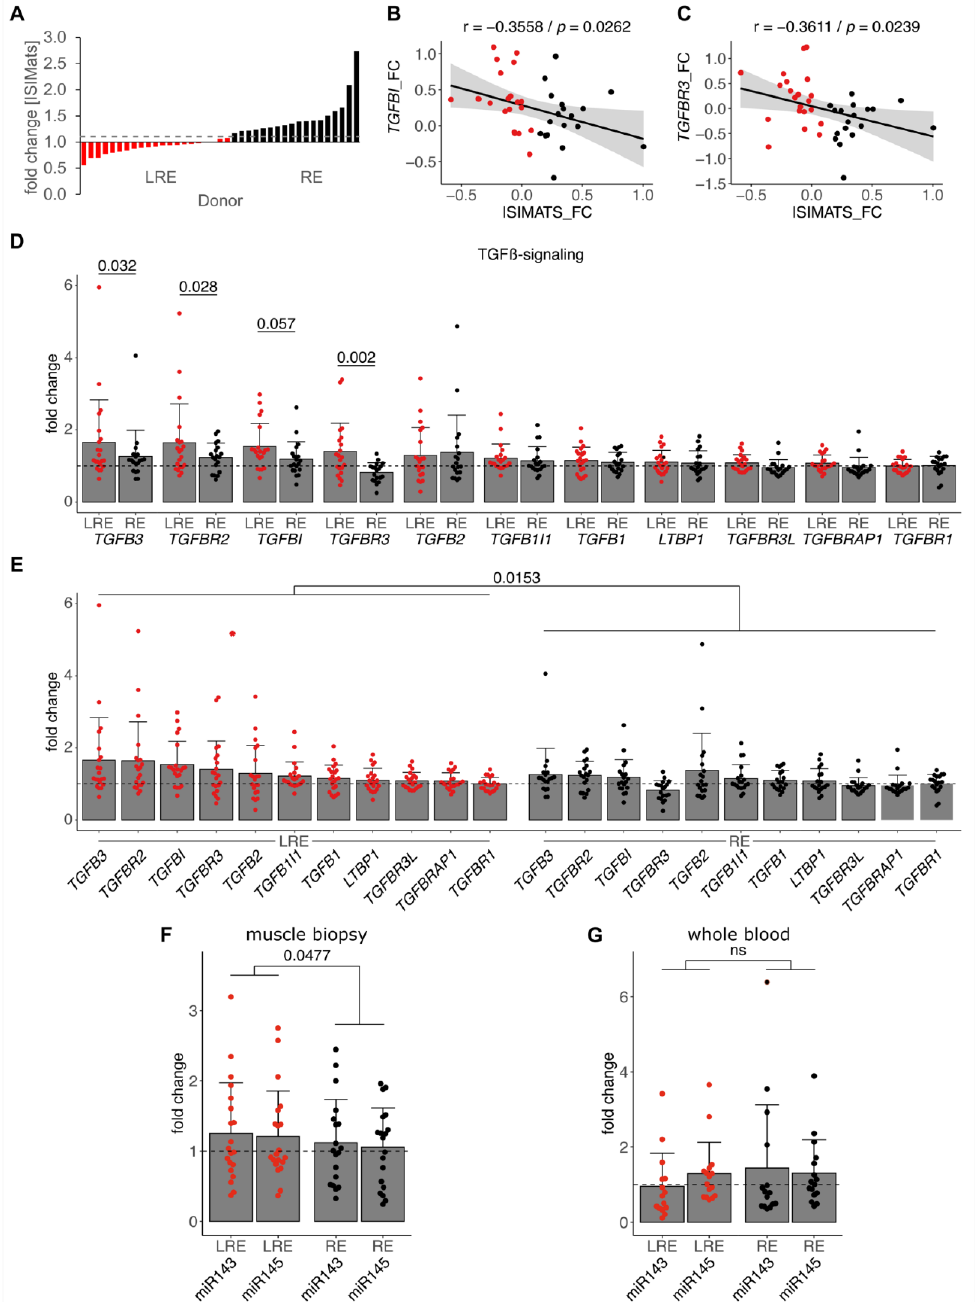
Figure 3. Low responders show elevated TGF- β signaling and miR-143/145 cluster induction by training. ( A ) Middle-aged sedentary individuals ( n = 40) were grouped into low responders (LRE, red) and responders (RE, black) based on their improvement (fold change > 1.1) in insulin sensitivity (ISIMats) after 8 weeks of training intervention. RNA isolated from muscle biopsies before and after training was used for transcriptome analyses. ( B , C ) Correlation analyses of log- transformed fold changes (after intervention vs. before intervention) in ISIMats and fold changes of TGF- β target gene TGFBI and TGFBR3 transcripts in muscle biopsies was performed. ( D , E ) Fold change expression (after intervention vs. before intervention) of genes annotated in the term TGF- β signaling (GO:0007179) and detected by transcriptome analyses was compared between LREs and REs. Expression of mature miRNA cluster miR-143/145 was analyzed in skeletal muscle biopsies ( F ) and whole blood ( G ) by qPCR, normalized to individual donors and reference RNU6. Individual datapoints are displayed, bars represent mean ± SD. Data were analyzed using Pearson correlation ( B , C ), one-way ANOVA with Fisher’s LSD post-hoc test ( D ) or a paired linear mixed model ( E – G ). p -values are